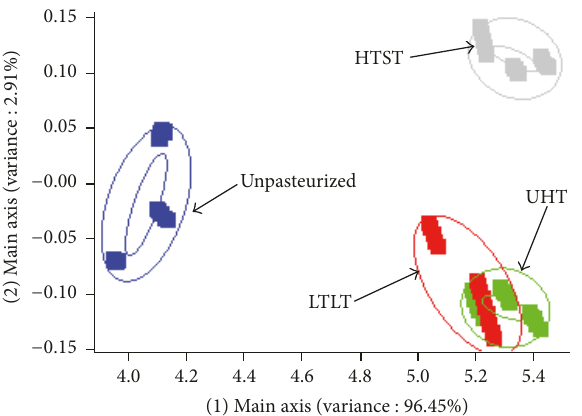
Figure 3: Effect of thermal treatments on the aroma of the water- melon juice. UHT: ultrahigh temperature; LTLT: low temperature long time; HTST: high temperature short time.